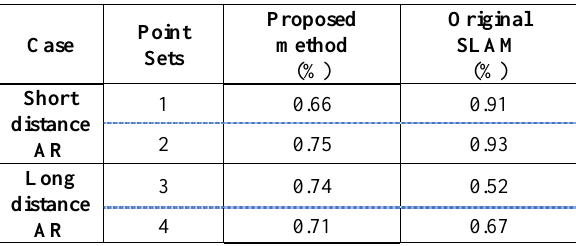
Table 2 . Reprojection RMSE error as a ratio for various anchor